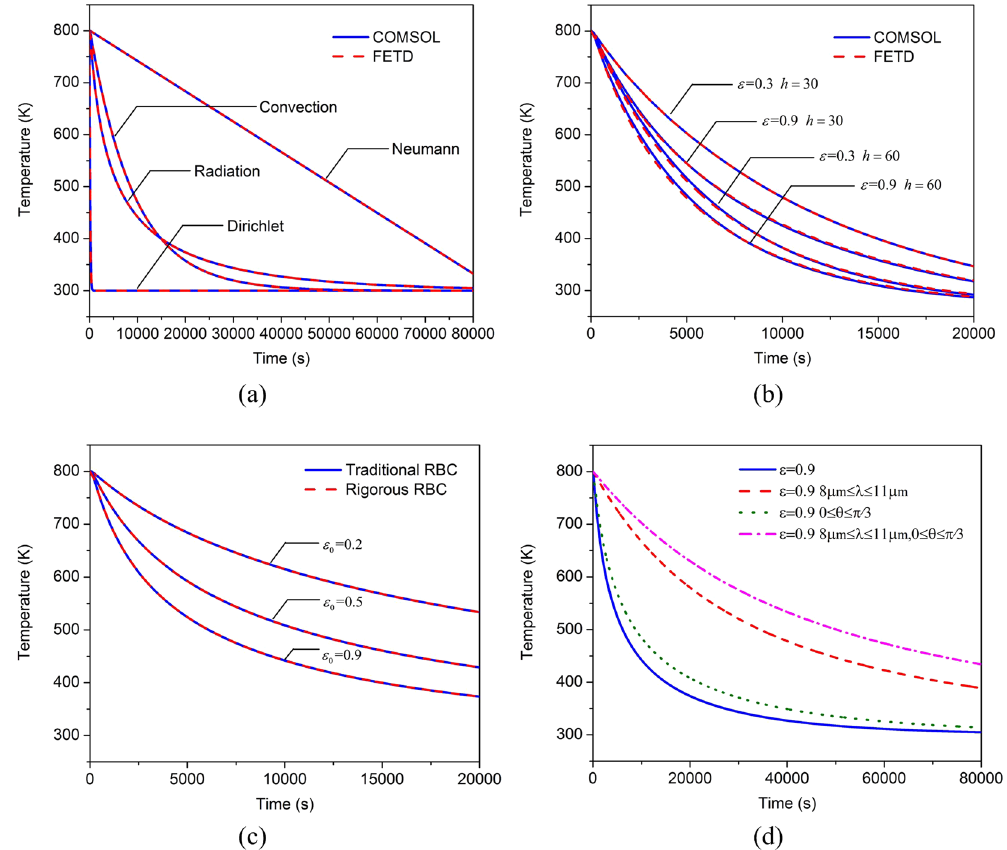
Figure 5. The temperature at the observation point obtained by ( a ) the proposed method and the COMSOL software with the Dirichlet, Neumann, convection and traditional radiation boundary conditions imposed to the whole boundary surface of the cube, ( b ) the proposed method and the COMSOL software with the Neumann boundary condition applied to the surfaces at x = 0 and x = 0.5, convection boundary condition applied to the surfaces at y = 0 and y = 0.5, and traditional radiation boundary condition applied to the surfaces at z = 0 and z = 0.5, ( c ) the traditional radiation boundary condition and rigorous radiation boundary condition, ( d ) the rigorous radiation boundary condition with the surface emissivity depending on the wavelength and emission